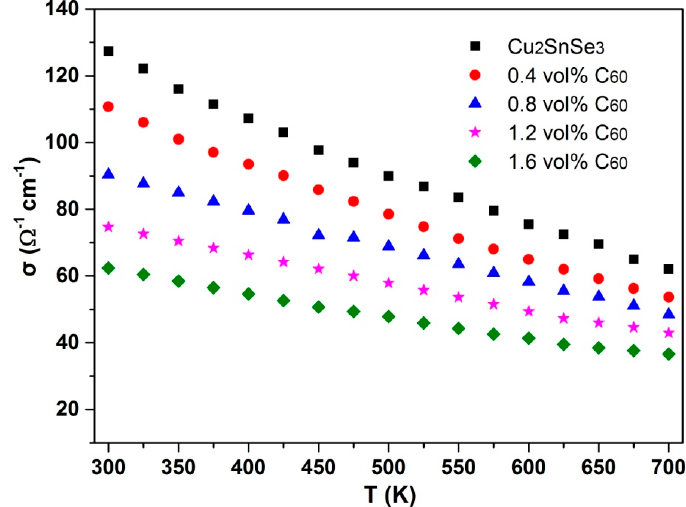
60 /Cu 2 SnSe 3 composites.